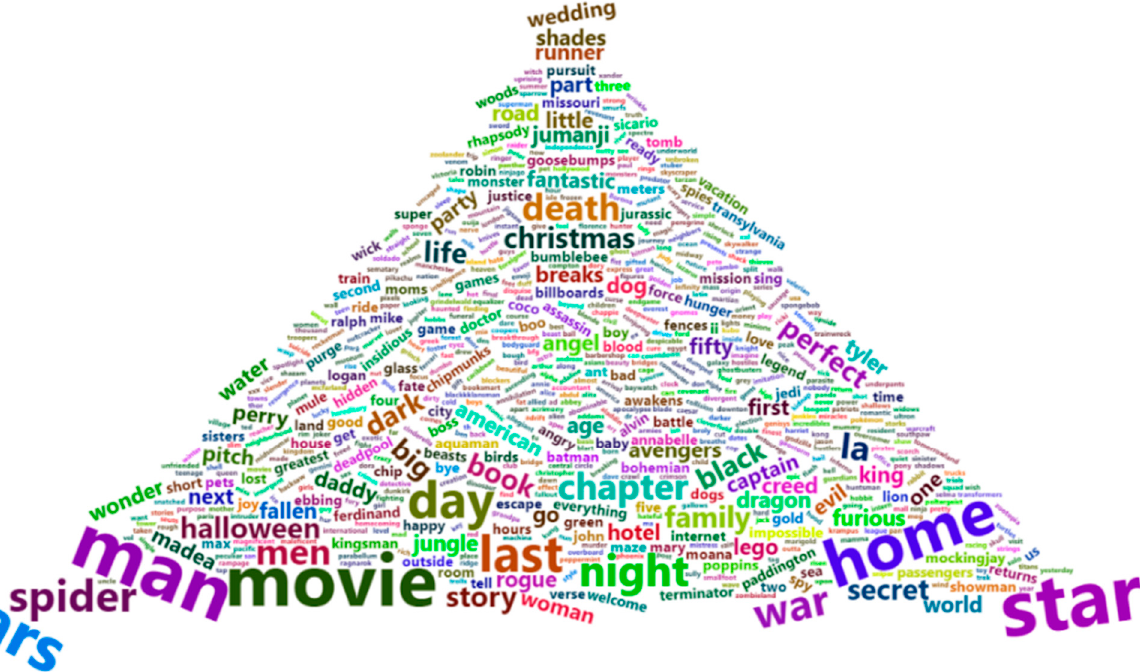
Figure 5. Word cloud of movie title keywords in the United States.